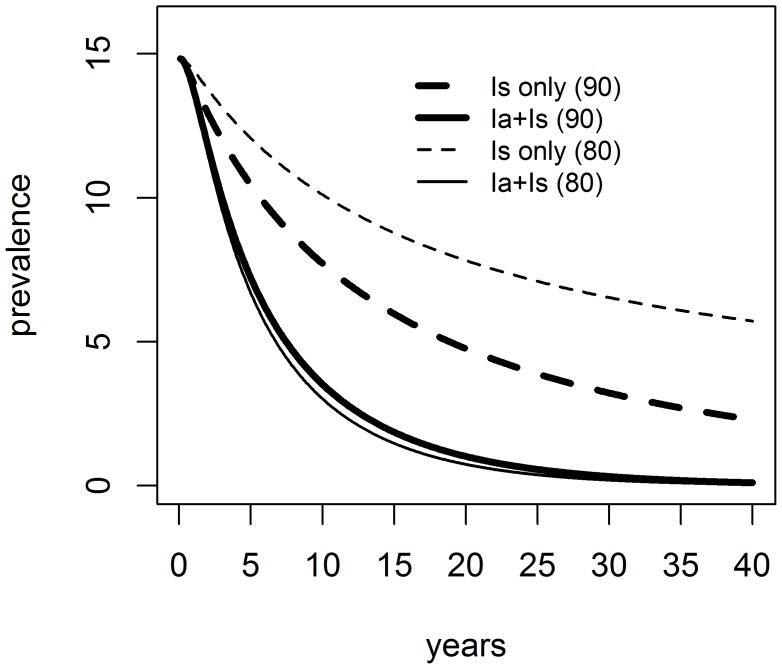
Prevalence of CVL in the higher endemicity area under four control programs differing in their target and in diagnostic test used.“Is only” = control program targeting only symptomatic dogs, “Ia + Is” = targeting asymptomatic and symptomatic dogs; the number between parenthesis indicates the sensitivity of the diagnostic test.